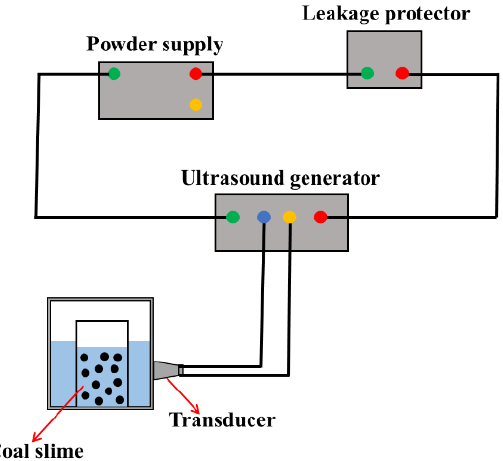
Figure 3. Schematic of the ultrasound equipment.